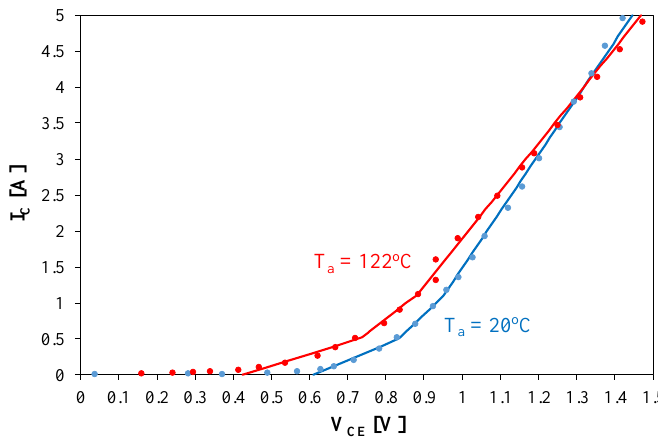
Figure 4. Output characteristics of insulated gate bipolar transistor (IGBT) computed with the use of a piecewise linear model (lines) and measured (points) at selected values of temperature T a .